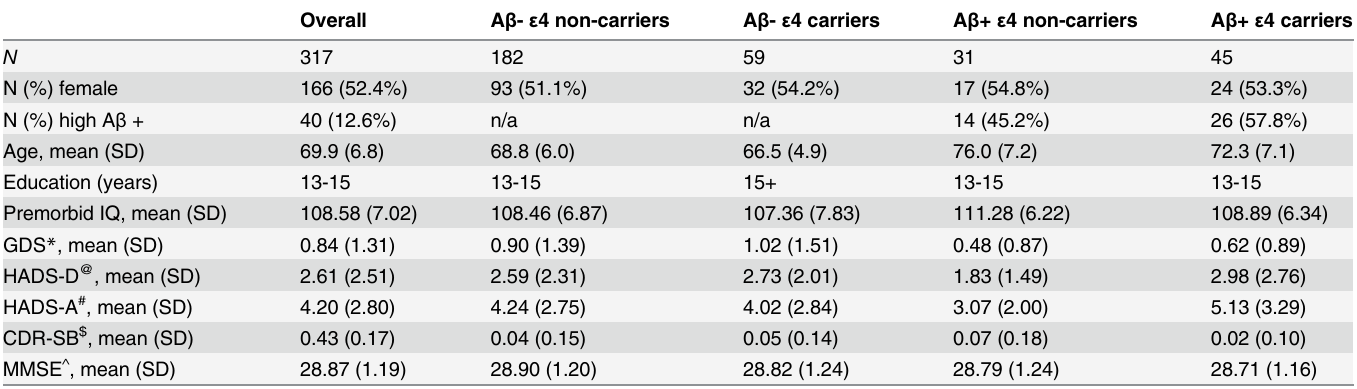
Table 1. Demographic and clinical